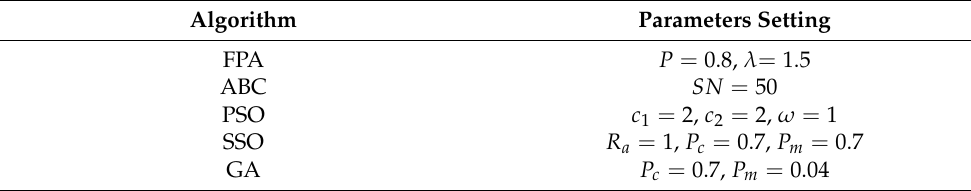
Table 1. Algorithm 1 parameters setting.